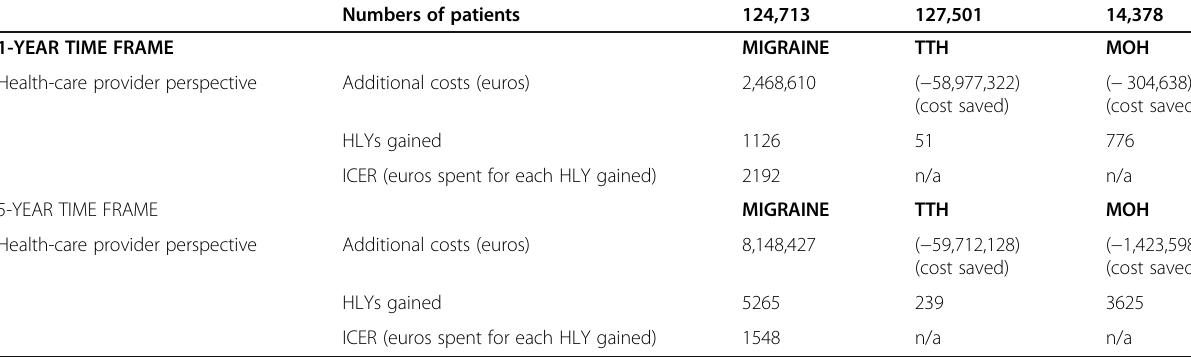
Table 1 Luxembourg: economic consequences of changing from current to target care (population